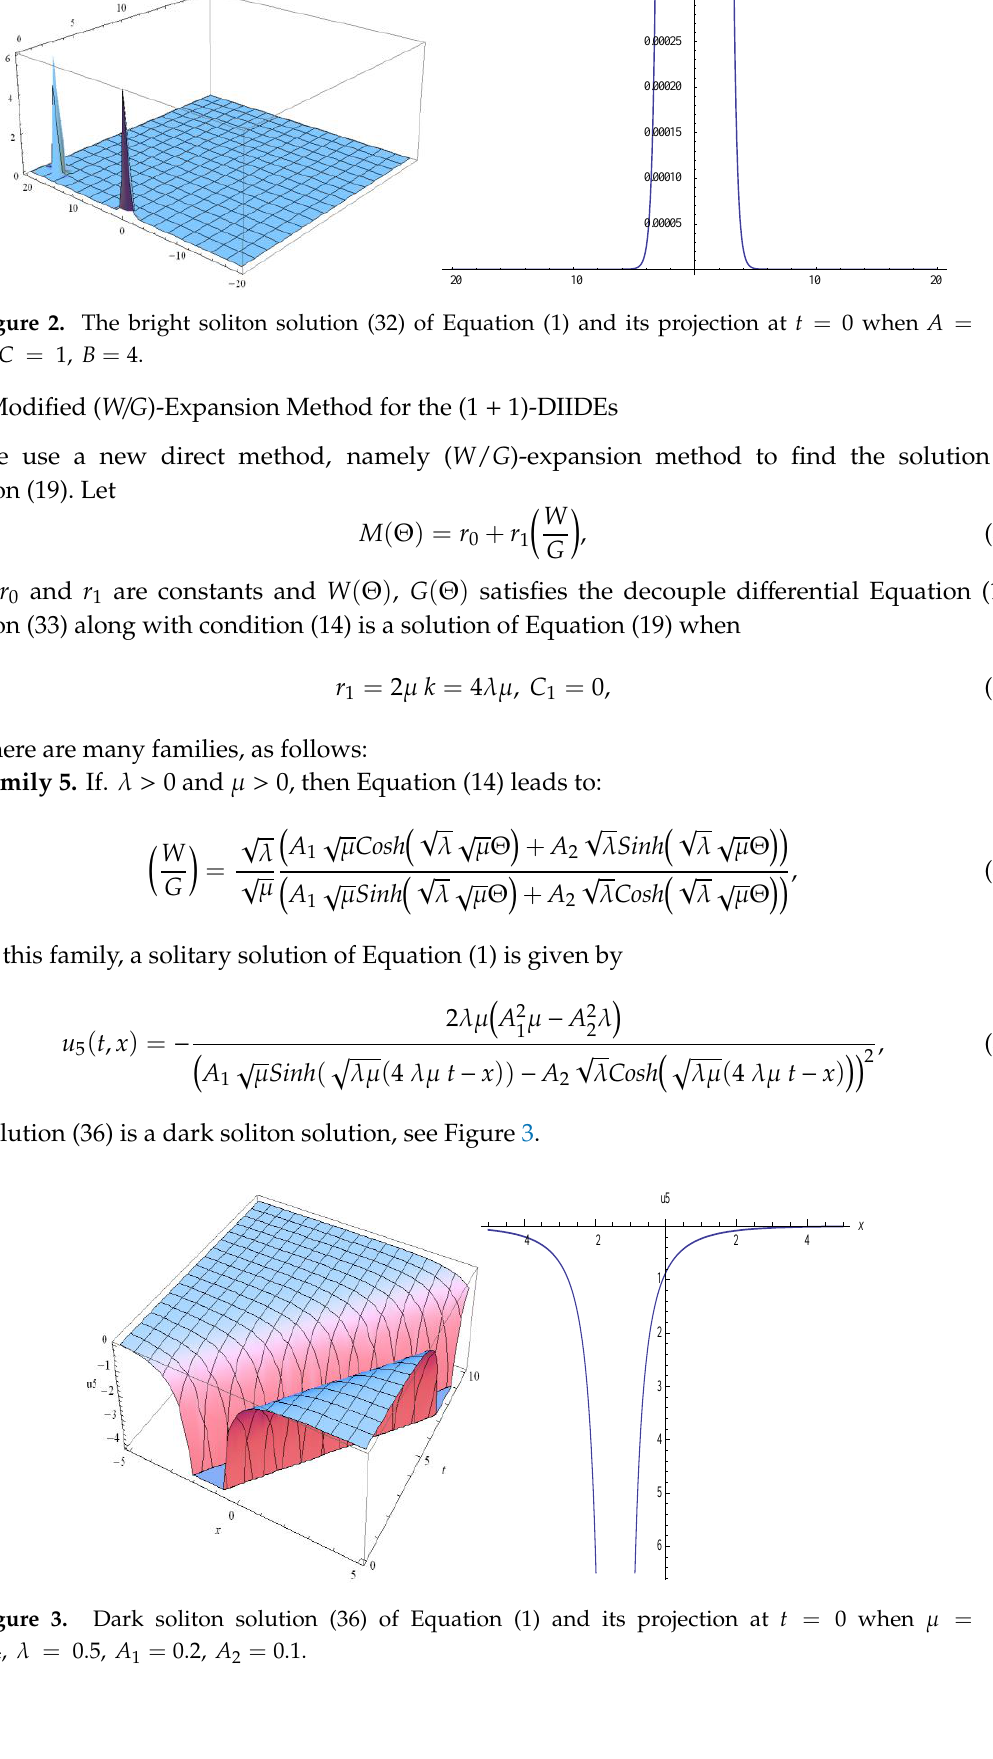
Figure 4. Singular periodic solutions (40) of Equation (1) and its projection at 𝑡 = 0 when 𝜇 = −0.3, 𝜆 = 0.9,𝐴 1 = 0.4, 𝐴 2 = 0.5 . In the above figures, we illustrate the periodic soliton solution as you are shown in Figure 1, bright soliton solution in Figure 2, dark soliton solution appear in Figure 3 while the singular periodic solutions in Figure 4 to the (1 + 1)-DIIDEs. 3.2. Exact Solutions to Nonlinear Dispersive Schrodinger Equation (NDSE) In this section, we study the solution of NDESs 𝑖𝑢 𝑥 − 𝑆 2 2 𝑢 𝑡𝑡 − 𝑖 𝑆 3 6 𝑢 𝑡𝑡𝑡 − 𝑆 4 24 𝑢 𝑡𝑡𝑡𝑡 + 𝐿 2 |𝑢| 2 𝑢 + 𝐿 4 |𝑢| 4 𝑢 = 0,